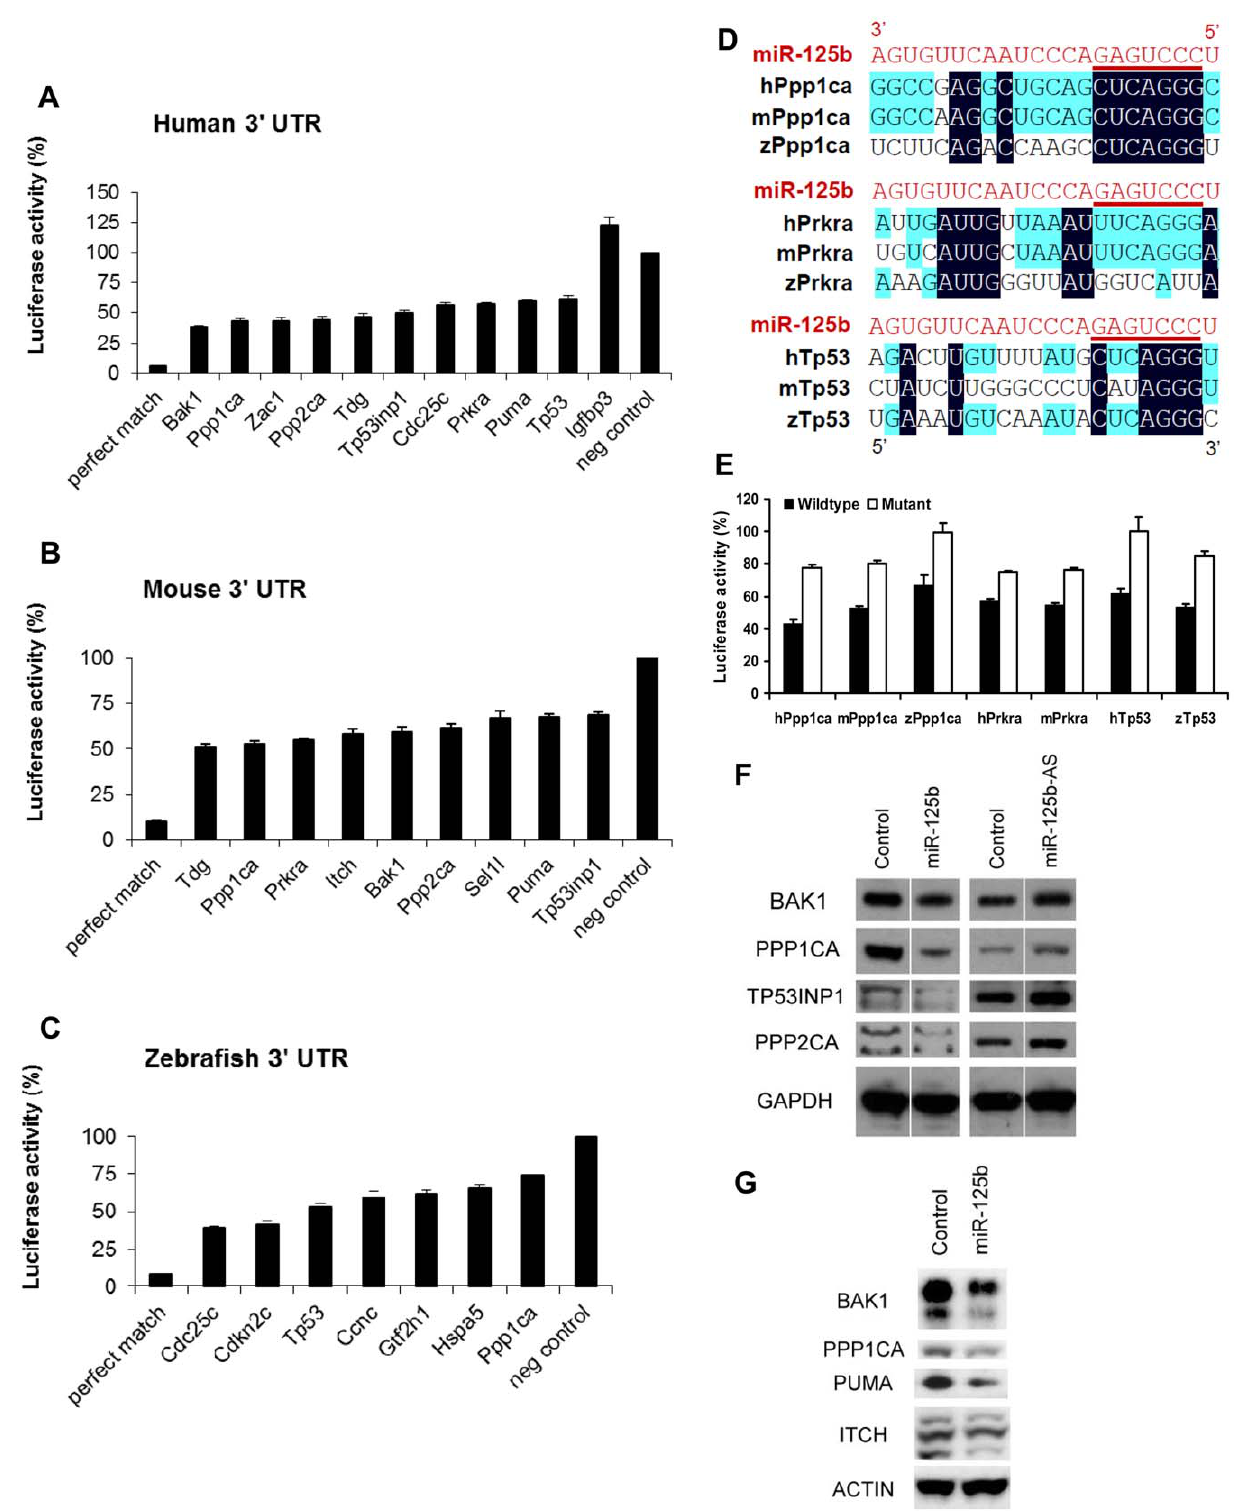
Figure 4. Validation of miR-125b targets. Candidate p53 network genes that were positive in both the GOF/LOF screen and miR-125b pull-down were validated for targeting by miR-125b using the 3 9 UTR luciferase reporter assay and Western blots for protein expression. (A-C), Reporter genes containing the full-length 3 9 UTRs of each selected target gene were co-transfected with miR-125b duplex into 293T cells. Luciferase readings were obtained 48 hours after transfection and presented here as the average percentage of luciferase activity 6 s.e.m. (n $ 3) relative to a scrambled duplex co-transfected control (100%). A reporter containing a 23-nucleotide-binding-site with perfect complementarity to miR-125b was used as the perfect match positive control, while the unmodified luciferase reporter was used as the empty negative control. (A) Human: 10 out of 13 candidate genes’ 3 9 UTRs showed significant repression by miR-125b relative to the control (p , 0.01). (B) Mouse: 9 out of 11 candidate genes’ 3 9 UTRs showed